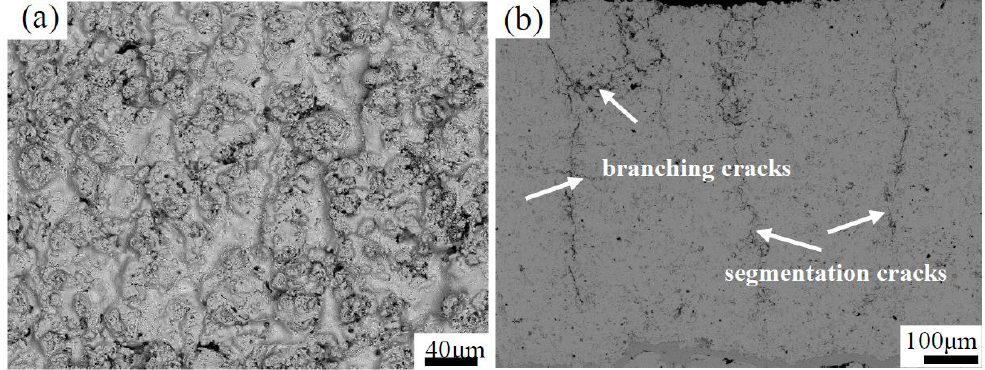
Figure 4. Surface morphology ( a ) and polished cross-section morphology ( b ) of as-sprayed APS top coatings.